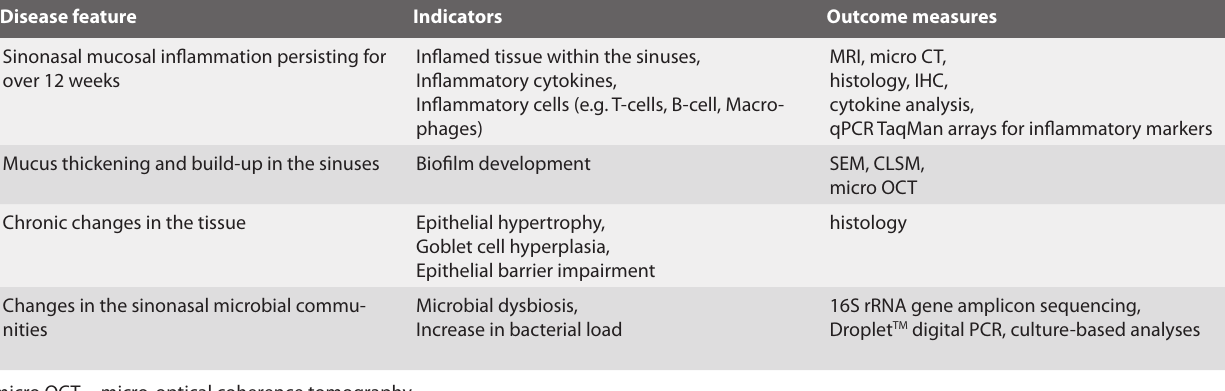
Table 2. Minimal disease features of CRS required in an animal